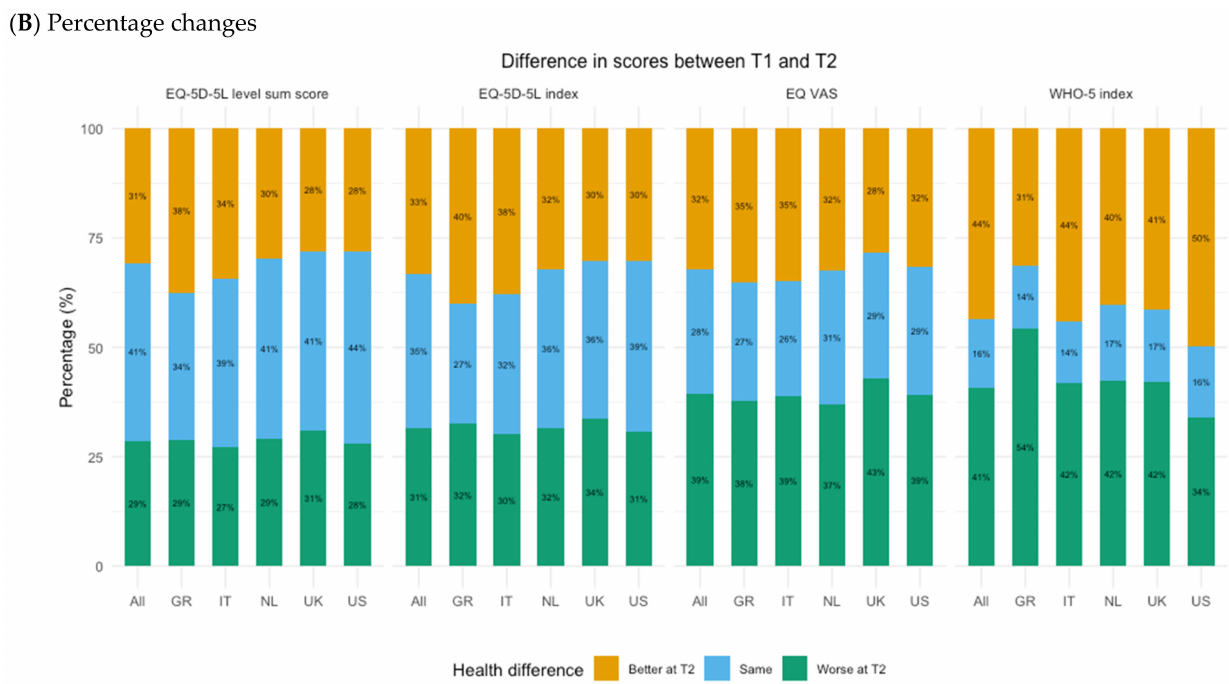
Figure 1. Changes in EQ-5D-5L scores (dimensions, level sum score, index, and EQ VAS) and WHO–5 index between T2 and T1 in all countries (N = 6765). Note to Figure 1B: Same: score at T1 = score T2; Better at T2: better health at T2 (T2 score >T1 if it was a positive score); Worse a T2: worse health at T2 (T2 score < T1). “ALL”, “GR”, “IT”, “NL”, “UK”, “US” represents “All countries”,